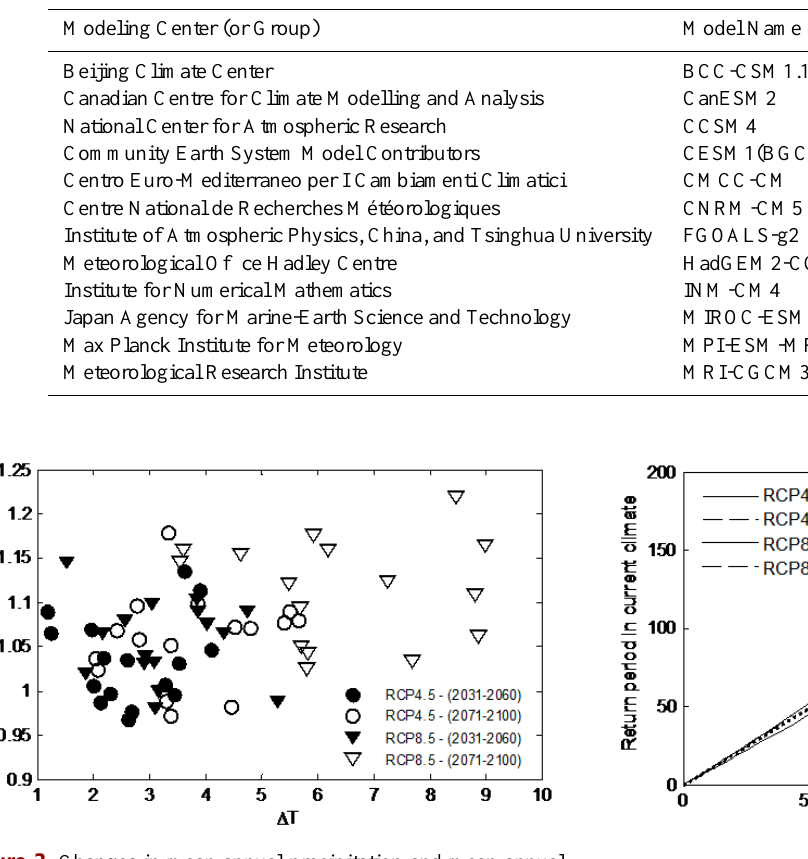
Figure 4. Current return periods plotted versus future return periods of spring peak runoff, as determined by the distributions for control and future climates. See main text for